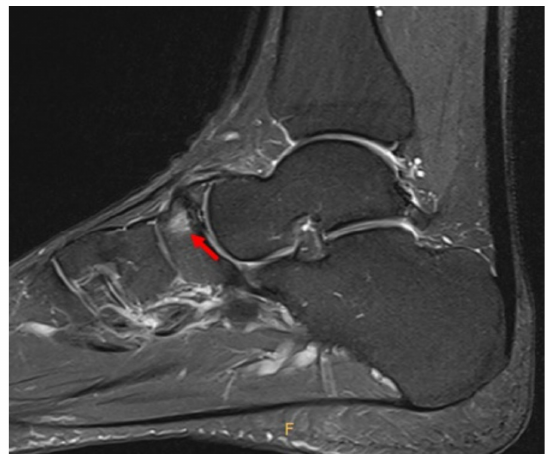
Figure 3. Preoperative proton density fat saturation MRI shows the fracture with high signal intensity at the same location as seen on CT scan (arrow).